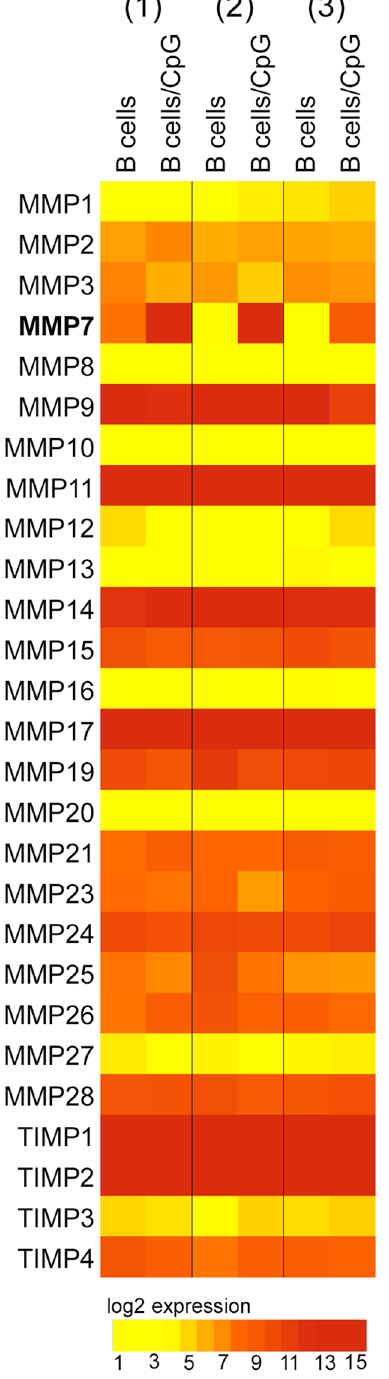
Figure 1. Heat map of MMPs and TIMPs expressed in human peripheral B-lymphocytes at baseline and after CpG stimulation. B-lymphocytes were isolated from peripheral blood of three different heathy donors. Cells were left untreated or stimulated with CpG for 72 hours. Gene expression profiles were generated using Affymetrix PrimeView chip from isolated RNA and analyzed using transcriptome console 3.0. Genes were considered increased from baseline if a change of at least 2-fold or greater was